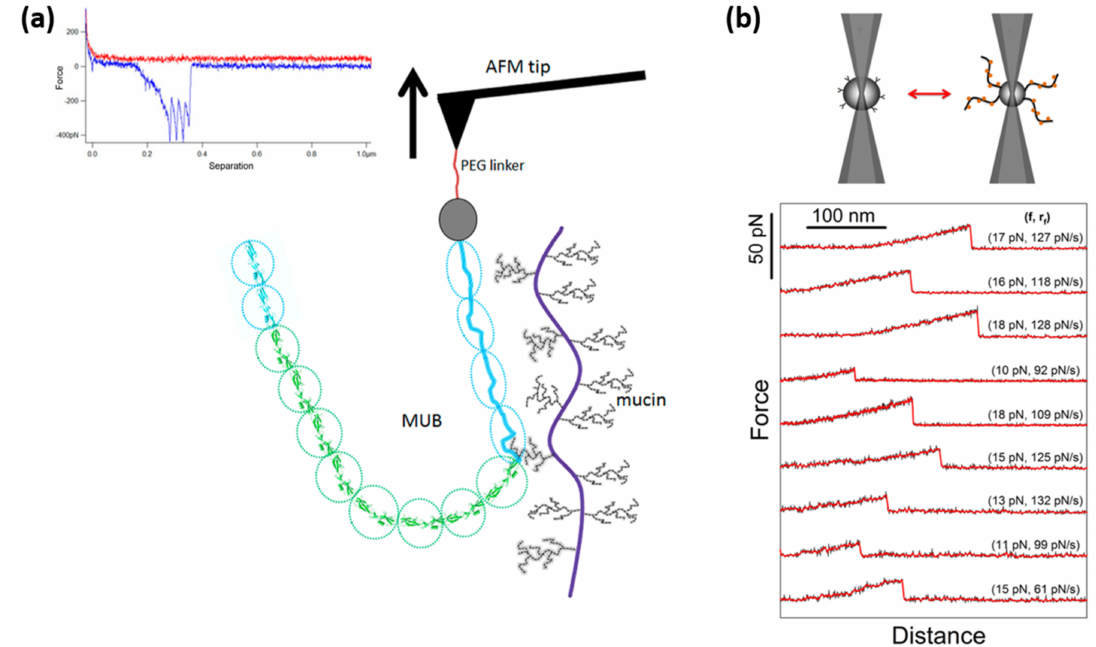
Figure 3. Non-pili based adhesions probed by AFM and OT. ( a ) AFM force curve and schematic representation of the interaction between a mucin-binding protein (MUB) from L. reuteri ATCC 53608 and mucins. The force curve shows four retract adhesion peaks corresponding to the unfolding of four type 1 MUB repeat domains (blue domains on the figure). Reprinted with permissions from [131]. ( b ) Schematic illustration of an OT system composed of two optically trapped beads functionalized with MUC1(ST), a mucin harboring α -NeuNAc(2-3) β -Gal(1-3) α -GalNAc-Ser/Thr glycans, and Macrophage galactose/N-acetylgalactosamine (GalNAc) specific lectin (MGL). The force diagram show typical force curves obtained when repeating approach–retract cycles for experimental series of MUC1(ST)–MGL. Reprinted with permissions from